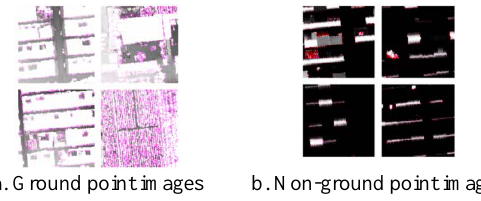
Figure 1. Feature images from (a) ground point and (b) non- ground point (Hu and Yuan, 2016).